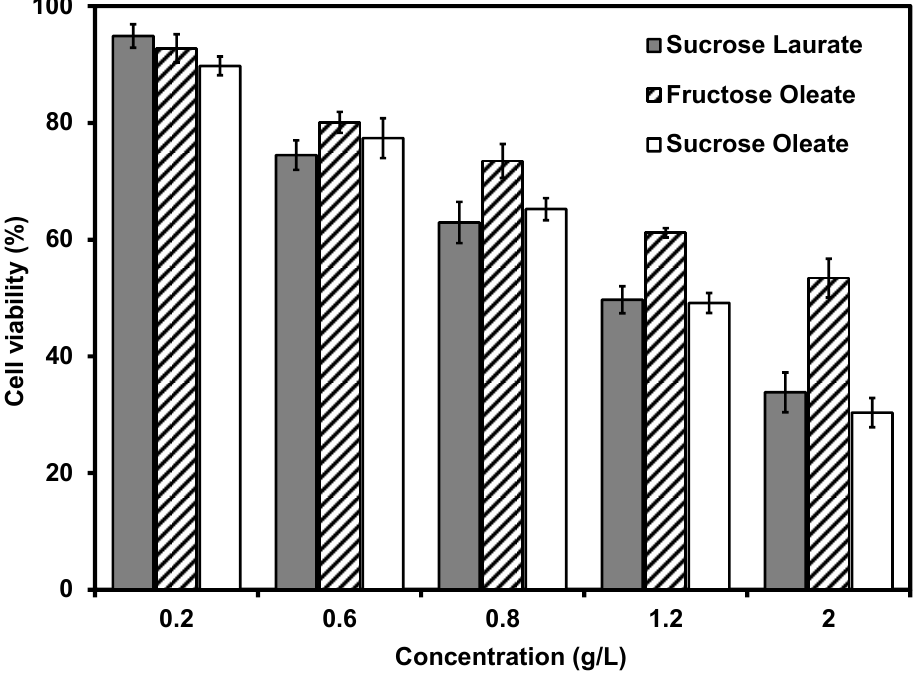
Figure 5. Antitumor activities of sugar fatty acid esters on ascitic tumor cells of Ehrlich carcinoma: sucrose laurate (black); fructose oleate (slash); and sucrose oleate (white).